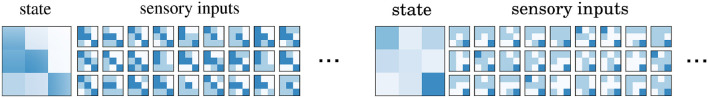
Examples of k-means clustering. Two states and example sensory inputs associated to each of these states by k-means clustering.